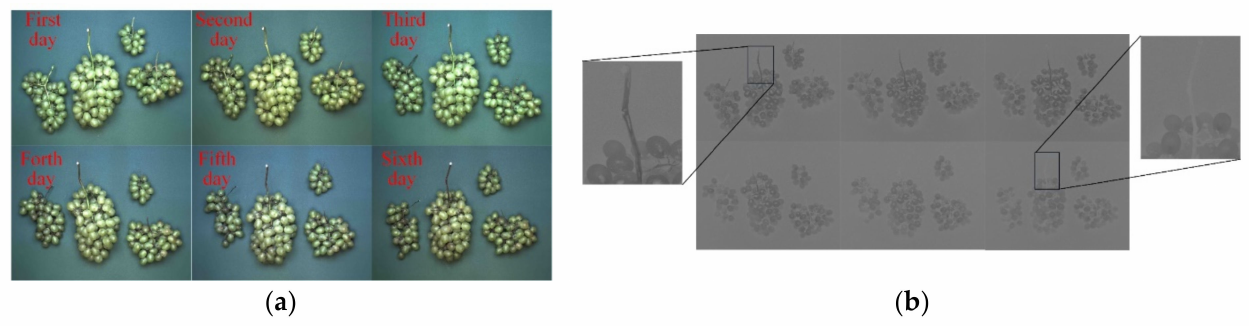
Figure 4. Fruit cluster freshness. ( a ) Color images; ( b ) Q